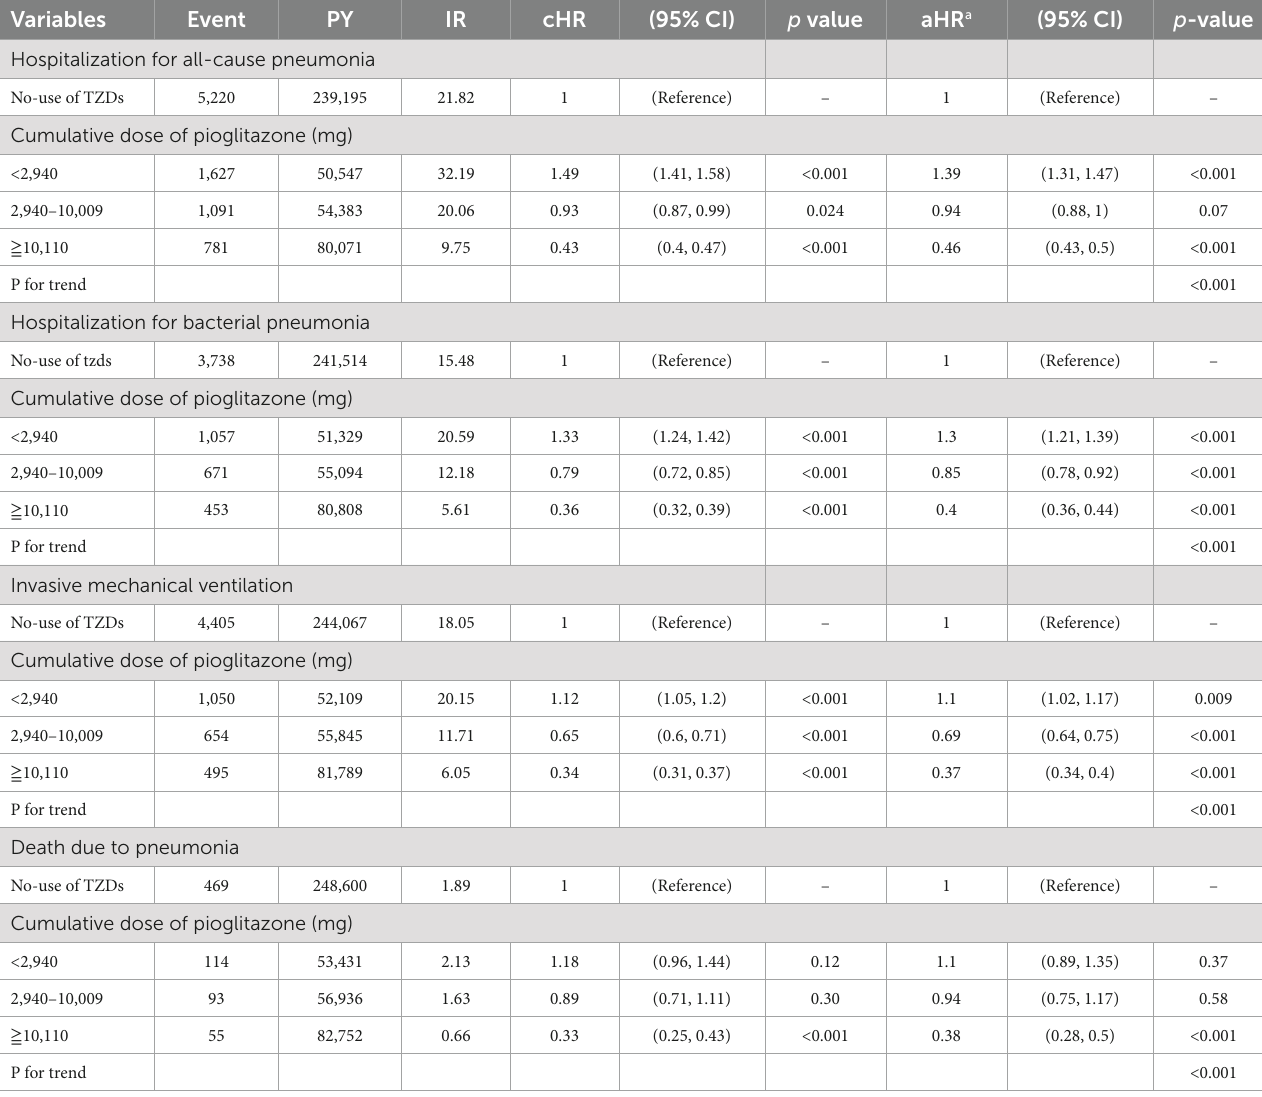
TABLE 5 Hazard ratios and 95% confidence intervals for outcomes with the cumulative dose of pioglitazone